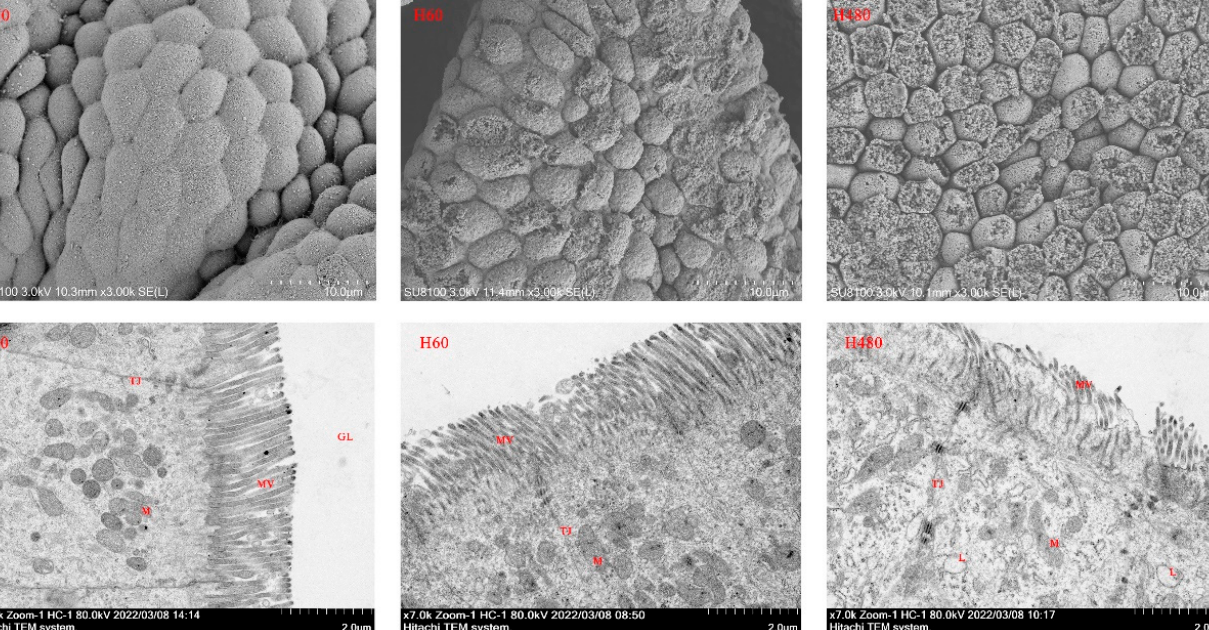
damage were clearly observed in the H480